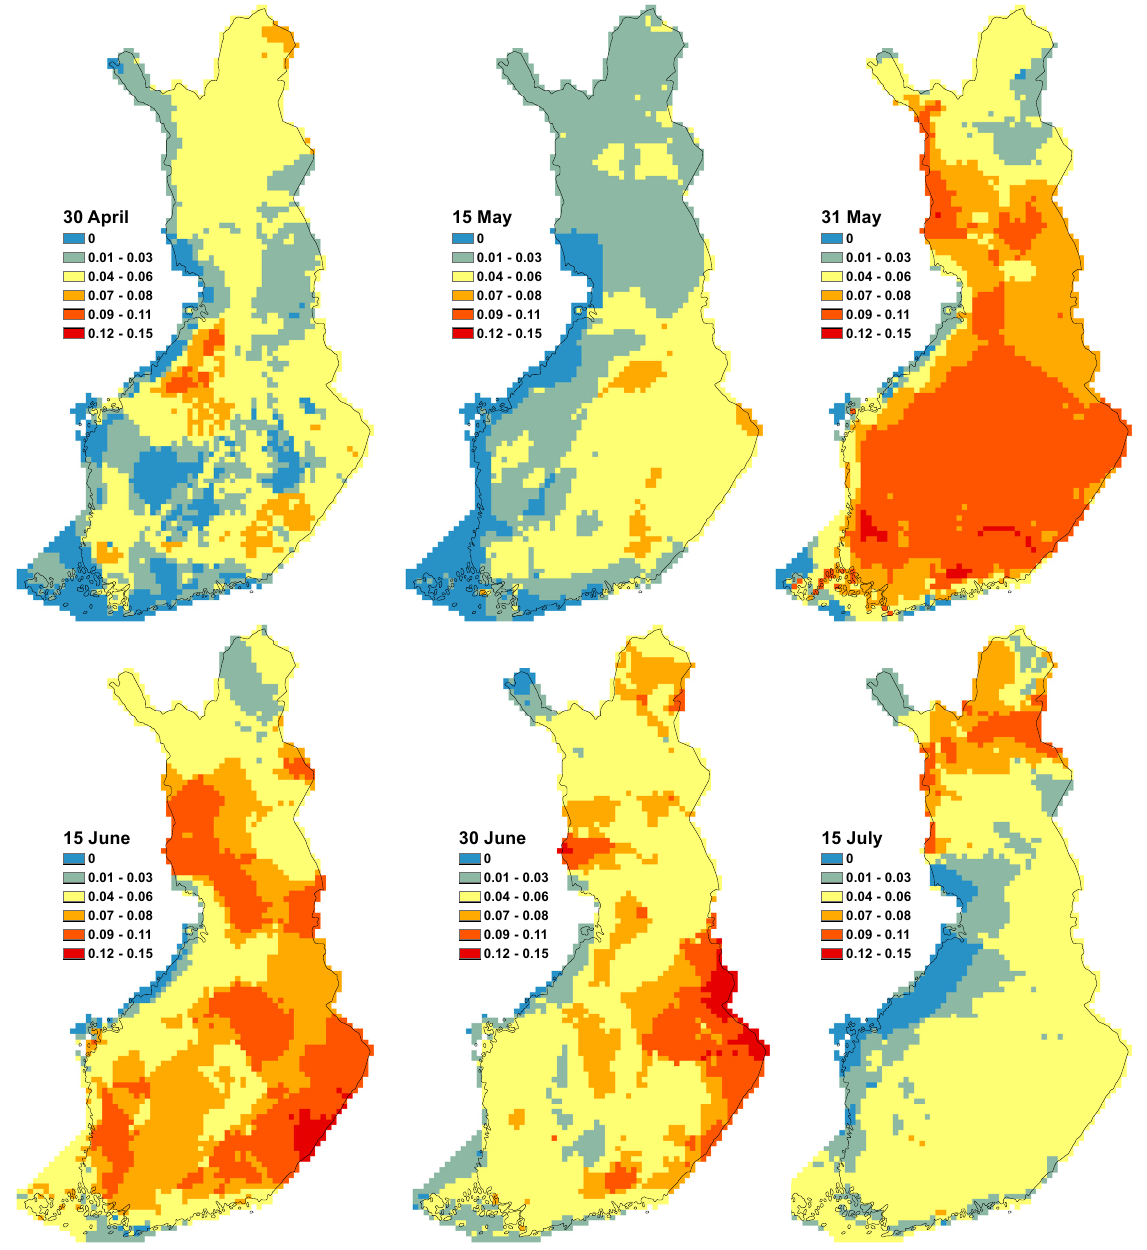
Fig. 1a. Probabilities of elevated temperatures of ≥3 °C that lasted for at least one week for the periods that ended on 30 April to 15